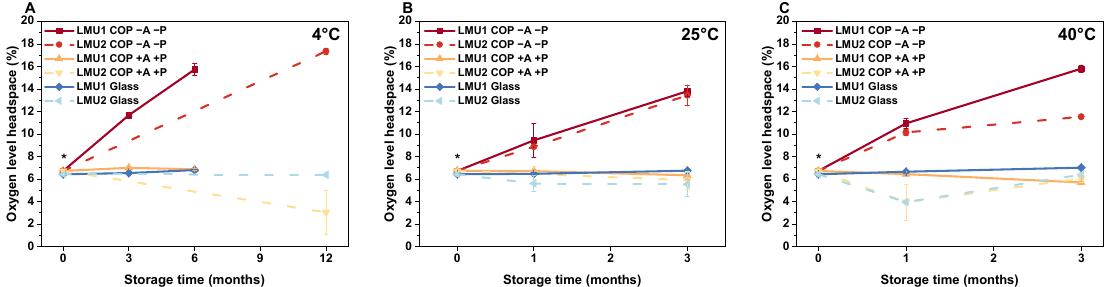
Figure 3. Oxygen levels in the headspaces of the lyophilizates containing LMU1 and LMU2 measured directly after freeze‐drying and after storage up to 6 months (LMU1) and up to 12 months (LMU2) at 4 °C ( A ), 25 °C ( B ), and 40 °C ( C ). Asterisks (*) represent repeated experiment for LMU2 because occasionally implausible initial data were obtained. The values are means ( n = 6 for LMU1; n = 3 for LMU2) ± standard deviation. COP, cyclic olefin polymer; A, absorber; P, pouch.